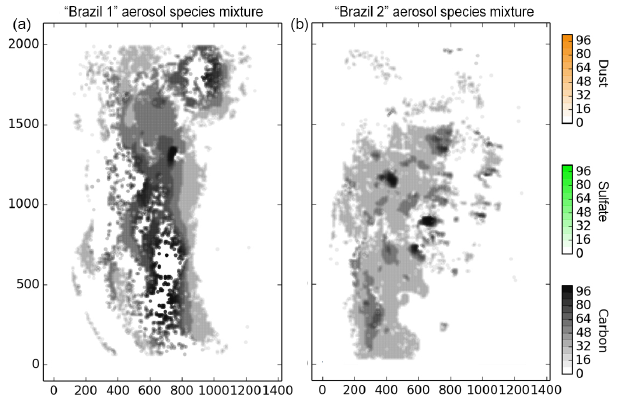
Figure 4. GEOS-5 aerosol species mixture for attempted MYD04 retrievals in Fig. 2. Panel (a) shows the Brazil 1 case (2012 day 252) and panel (b) shows the Brazil 2 case (2012 day 254). Both are dominated by carbon (smoke) aerosol.